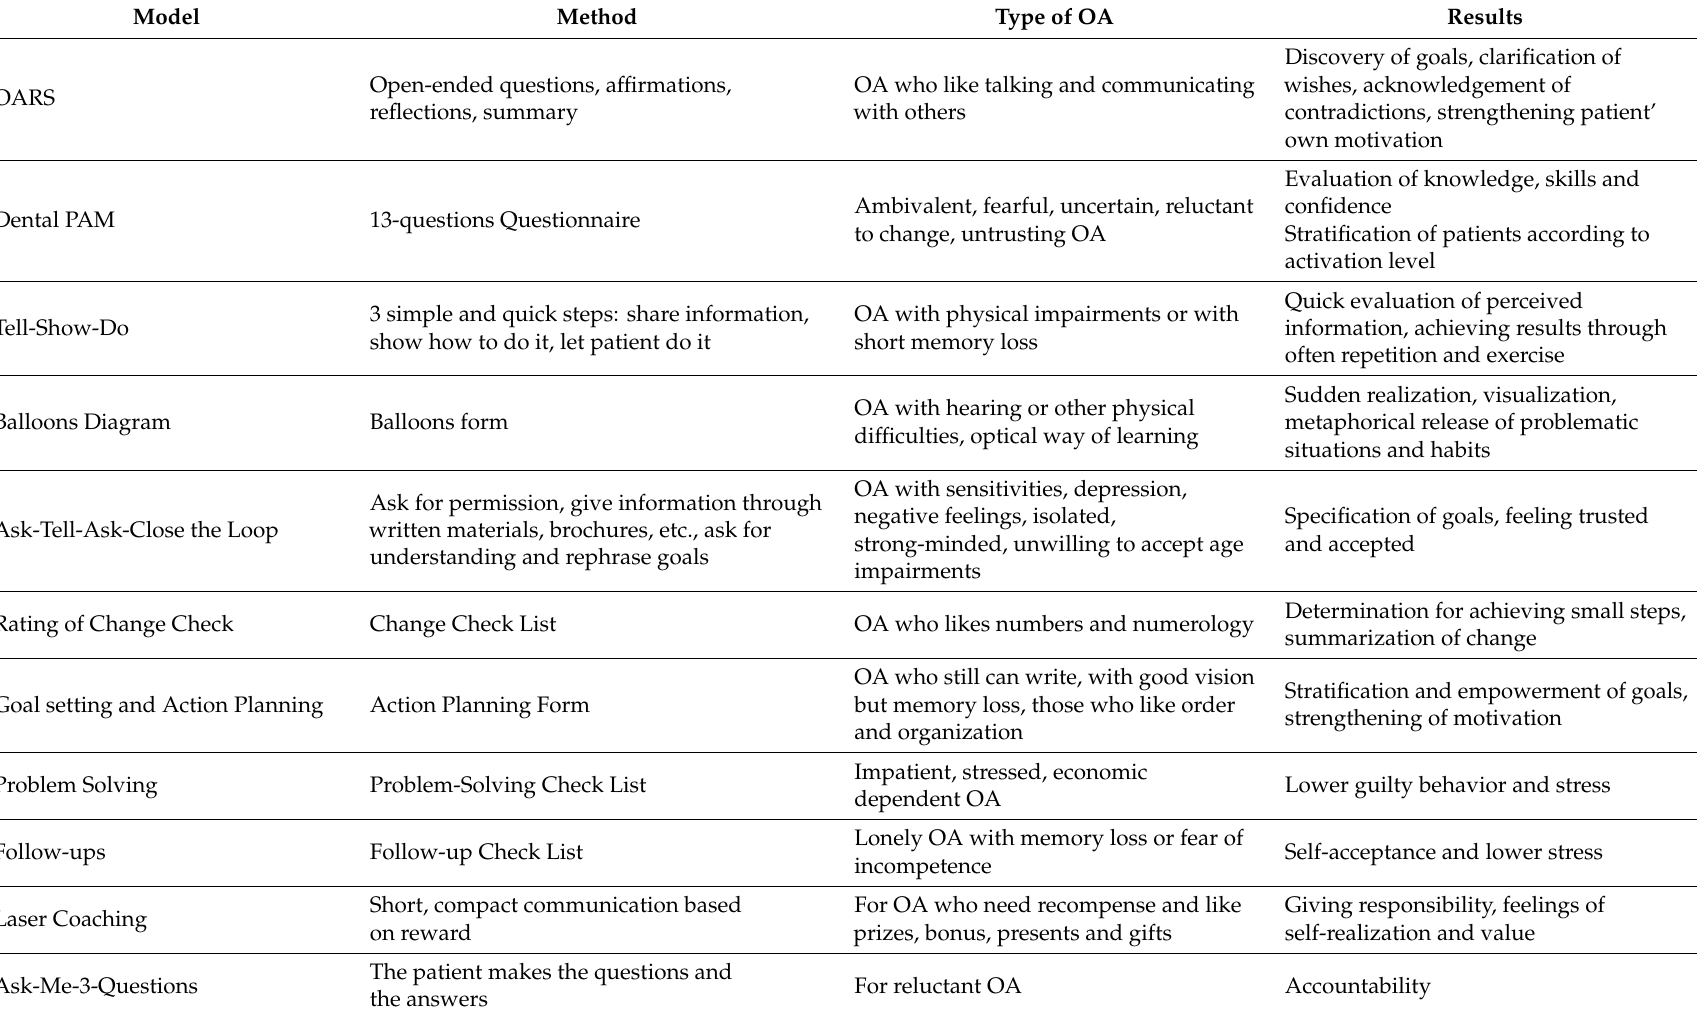
Table 3. Diet and oral health coaching models for